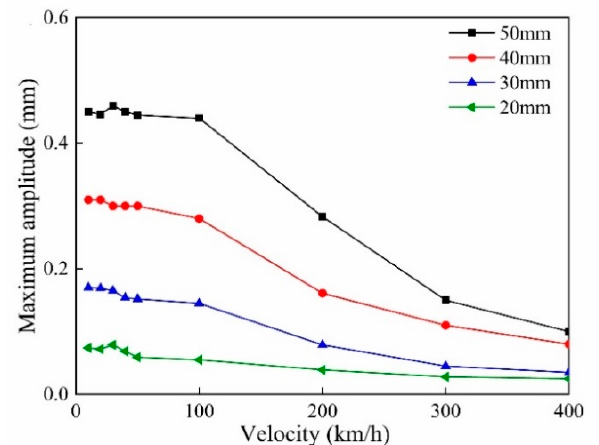
Figure 10. The impact response curves of the wheel flats at different speeds.